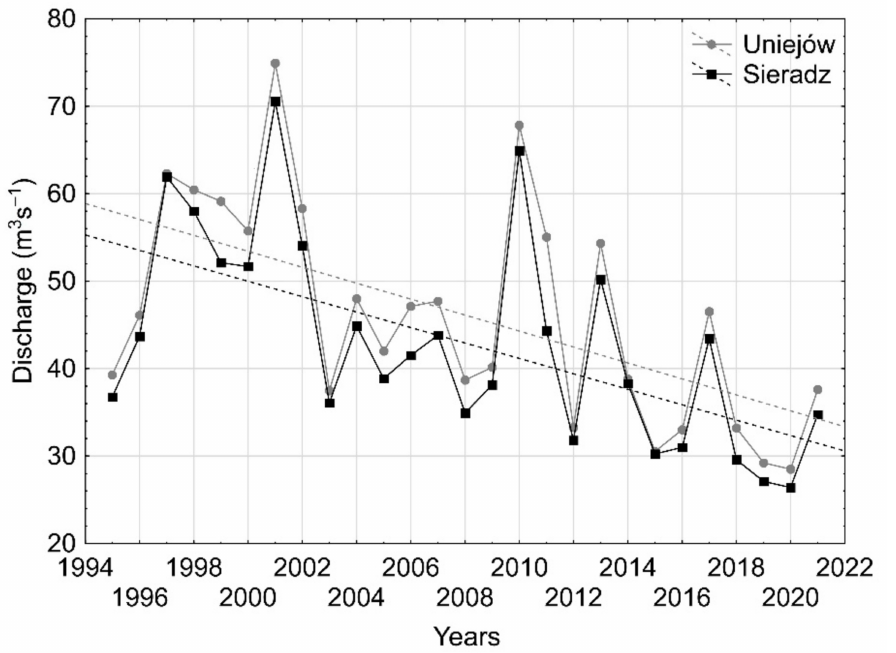
Figure 9. Changes in mean annual water flows in hydrological stations Sieradz and Uniej ó w in the period